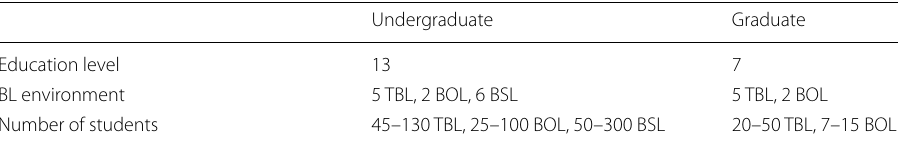
Table 1 BL course characteristics (n